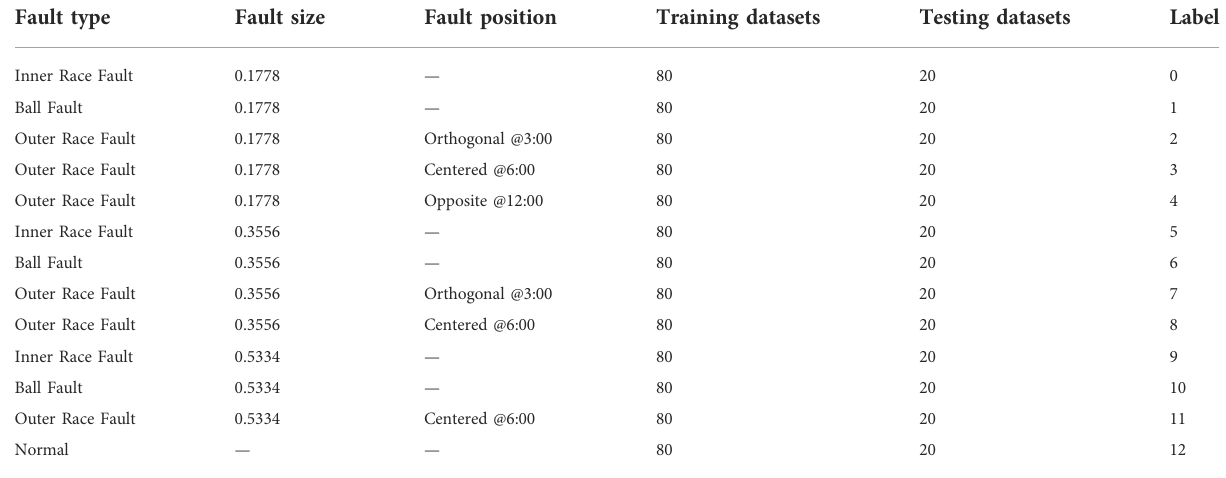
TABLE 1 Health conditions of bearing.